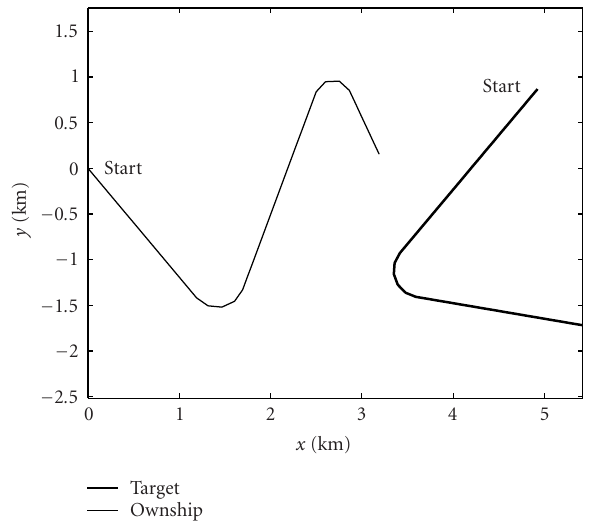
Figure 1: A typical bearings-only tracking scenario with a manoeu- vring